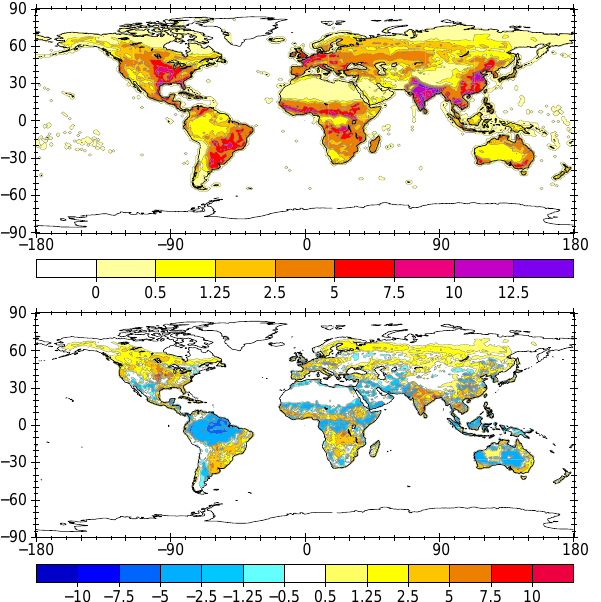
Fig. 9. Averaged SNO x flux in the whole simulation period (in ngm − 2 s − 1 ) for the YL95/SL11 simulation (upper panel) and the change compared to the YL95EMAC simulation (lower panel).